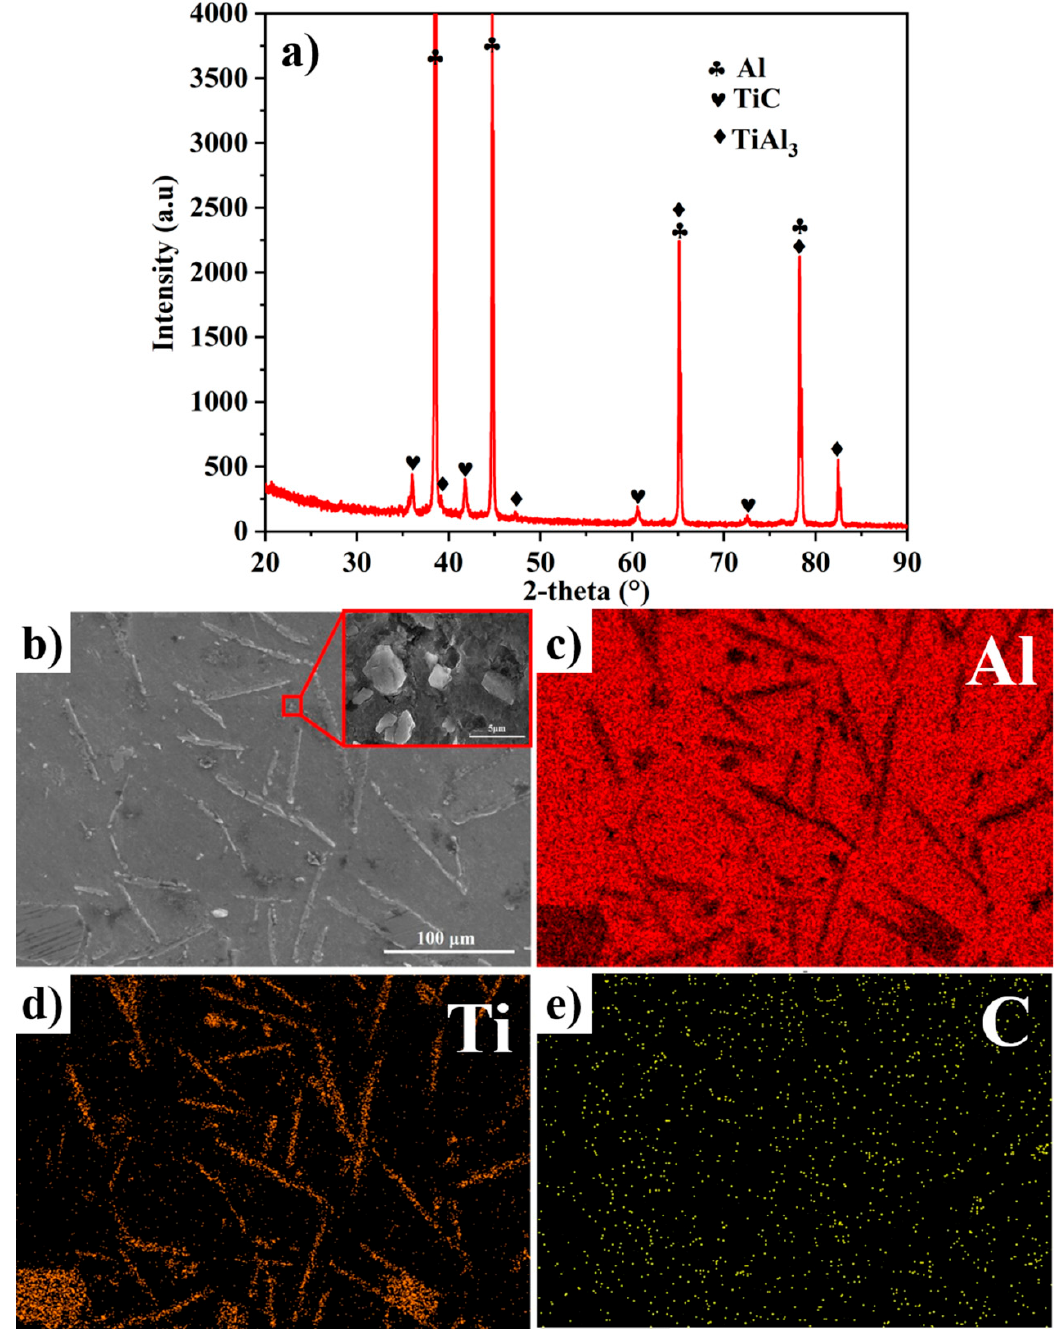
Figure 2. ( a ) The XRD pattern and ( b – e ) EDS elemental mapping of FW-1 at 90